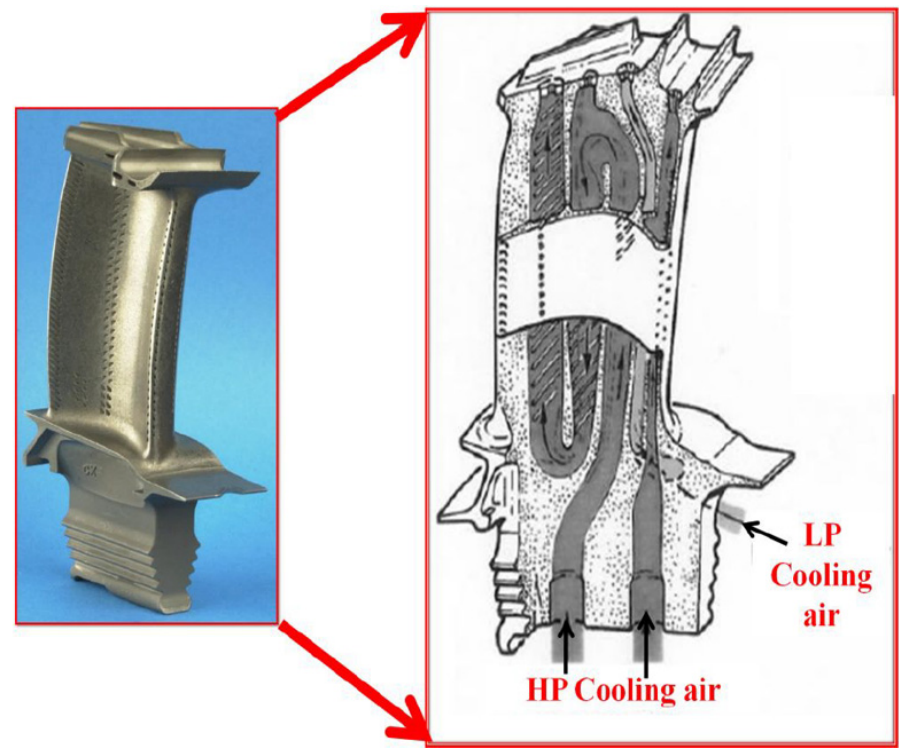
Figure 5. Trent 500 HP turbine blade [70].